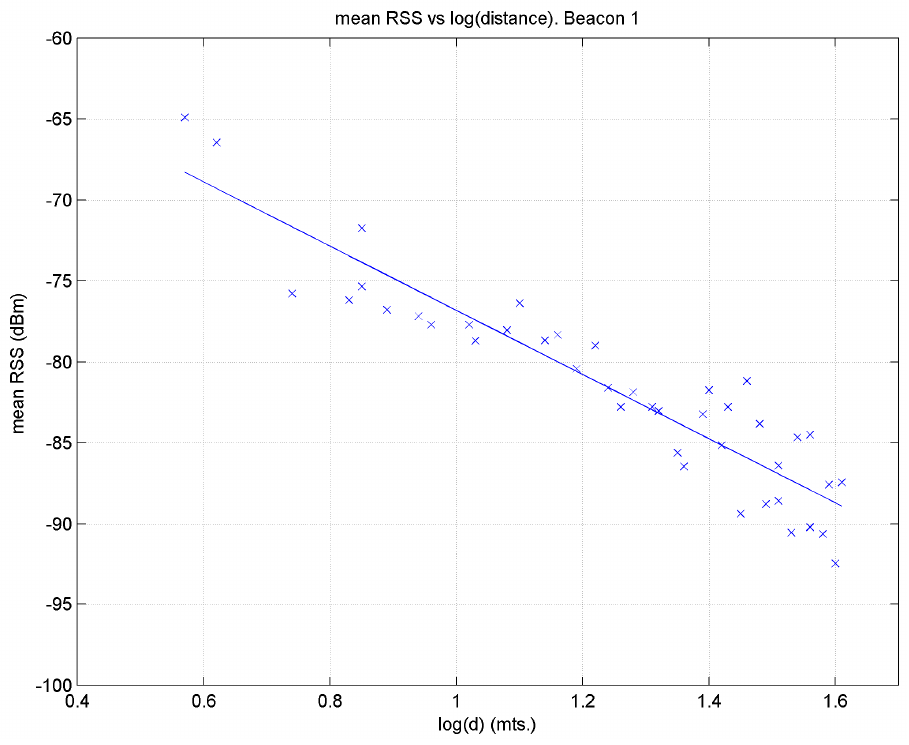
( b ) Figure 16. Histograms of RSS values for two beacons: ( a ) Beacon 1 in the absence of passengers; ( b ) Beacon 7 in the presence of passengers. 5.2.2. Empirical Approach to the BLE Tests The empirical approach followed was similar to that followed with Wi-Fi [34]. In this case, however, a grid of 22 cells, each measuring 2 m × 2 m with a density of 14.5 fingerprints per m 2 , was chosen initially (later increased to 42 cells), and seven BLE beacons were deployed (see Figure 5). For these tests, the configuration of each beacon was not very cost-effective in terms of battery consumption: at a frequency of 50 Hz and with an output power of 0 dBm. We should note that the beacons are located on alternate columns, which means a beacon at alternate bus stops. The density of beacons is not ideally suited to the purposes of our study (to